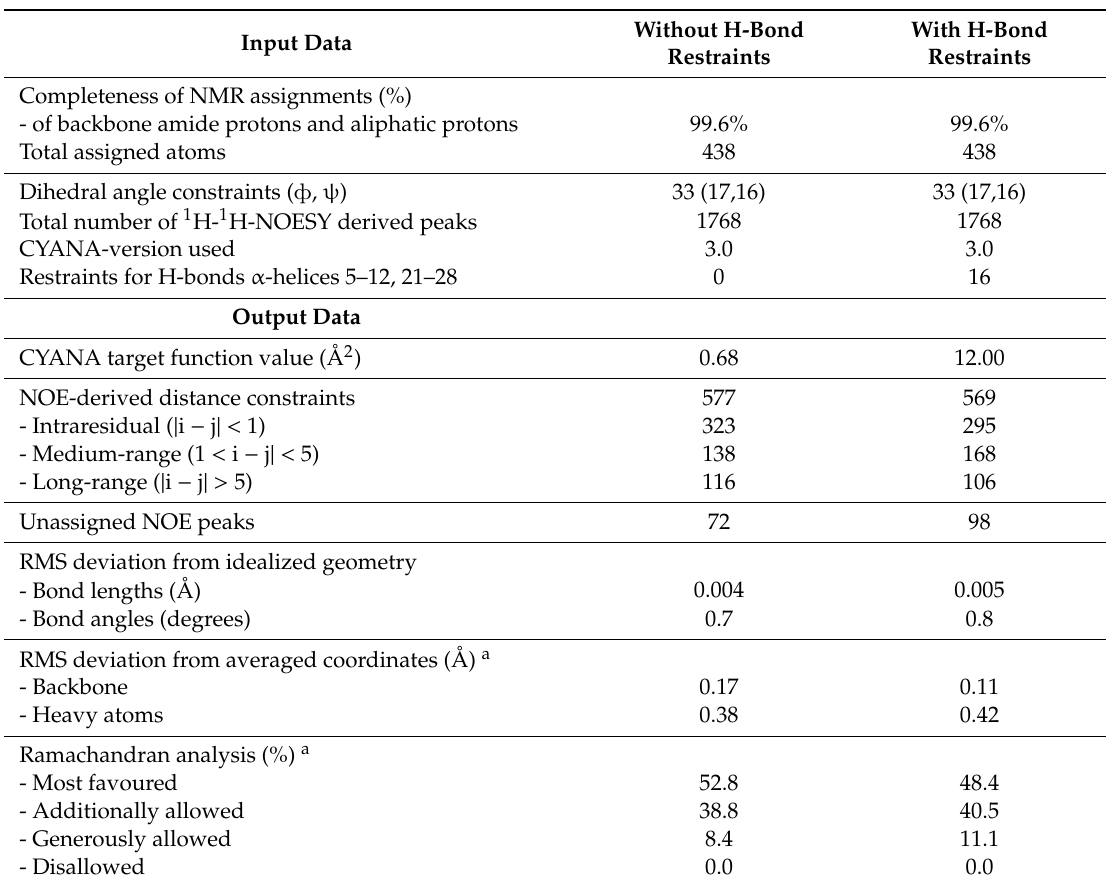
Table 2. Statistics for the NMR structure solution of ASM1 (H-bonds: Hydrogen-bonds; a: for residues 1–27). Input